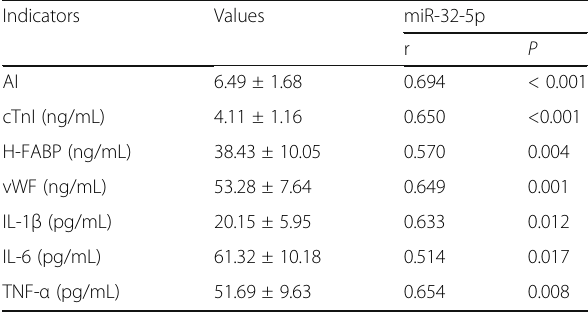
Table 2 Correlation of miR-32-5p with AI, serum levels of myocardial damage and endothelial injury markers and pro- inflammatory cytokines Indicators